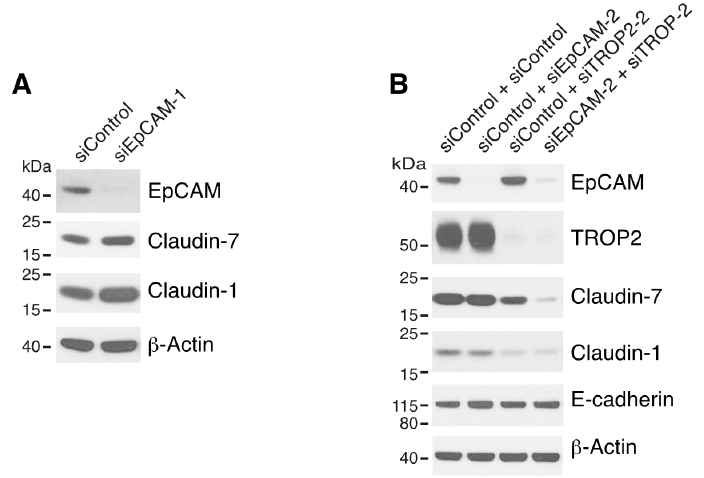
Figure 1. Expression of HAI-1, HAI-2, matriptase, EpCAM, and TROP2 in skin and intestine.